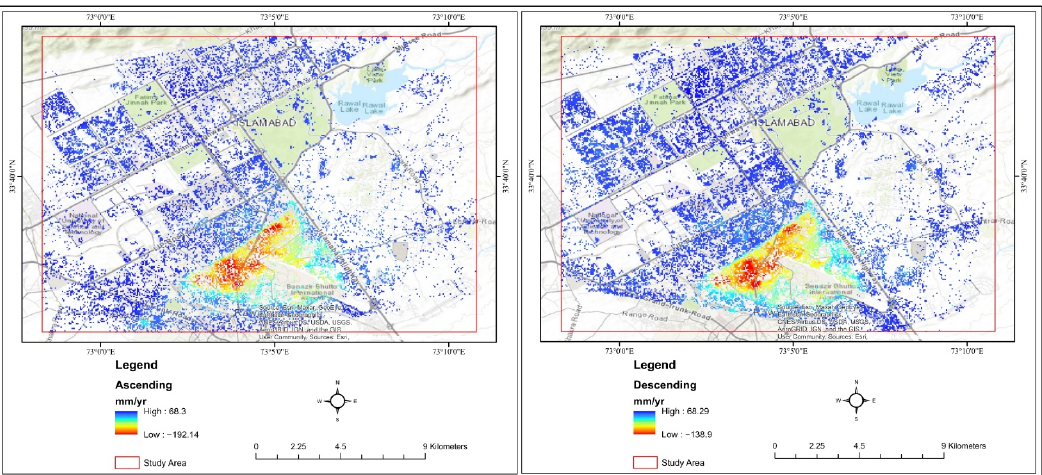
Figure 9. Land subsidence in the research area from ascending and descending paths. The finalized subsidence map was obtained from 2019 and 2020 to investigate sub- sidence in the study area yearly to evaluate the subsidence rate of different PS sites over the research time interval (Figure 10). As illustrated in Figure 10, a huge fluctuation was found in the subsidence values from 2019 to 2020; the subsidence value in 2019 ranged from − 69.33 to 77.1 mm/yr, while the subsidence value in 2020 ranged from − 98.56 to 36.7